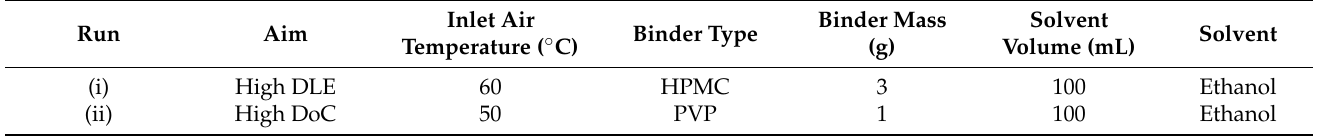
Table 3. Runs carried out in conjunction with the